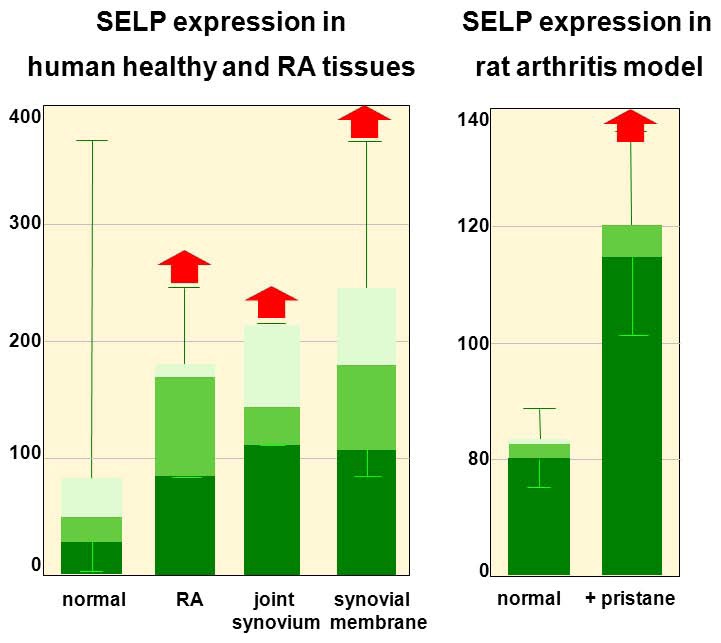

SELP expression profiles for human RA compared to healthy tissue and pristane induced arthritis in rat.Data derived from Gene Expression Atlas (E-GEOD-7307). Nnormal = 679 (including healthy joint synovium and synovial membrane samples), NRA = 5, Njoint synovium = 3 (all healthy), Nsynovial membrane = 11 (Nnormal = 6, NRA = 5). Nrats-untreated = 5, Nrats+pristane = 5.